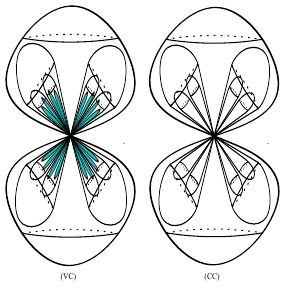
Figure 20. TI read by VC and CC at IML.